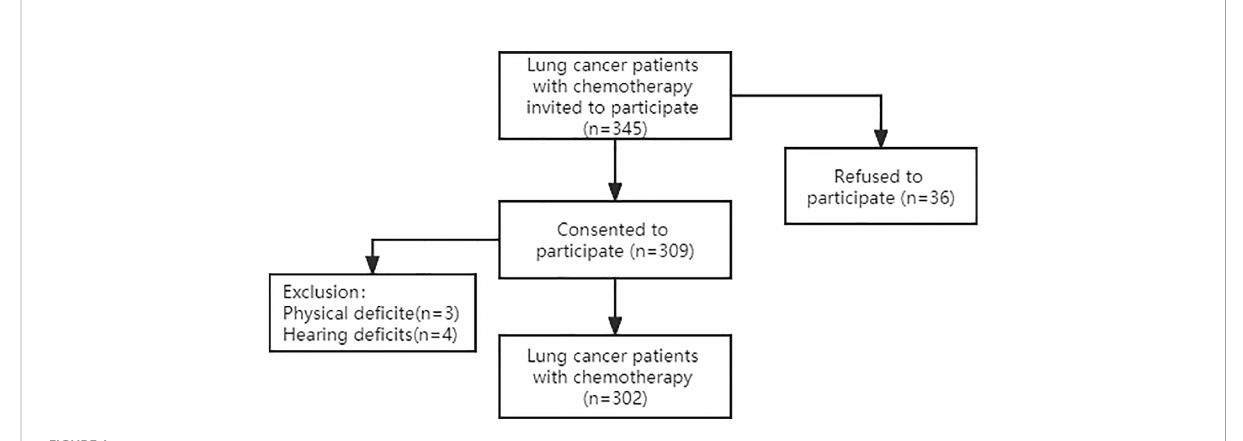
FIGURE 1 Flowchart of participants